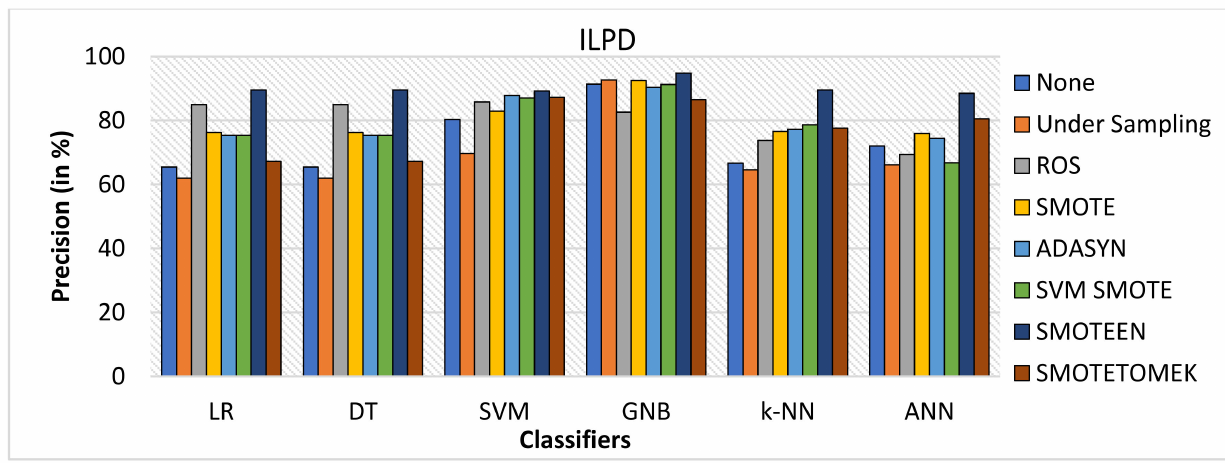
Figure 11. Precision for ILPD dataset of balancing algorithms over six